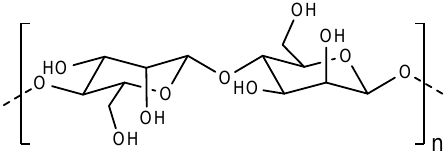
Figure 10. The structure of mannan.